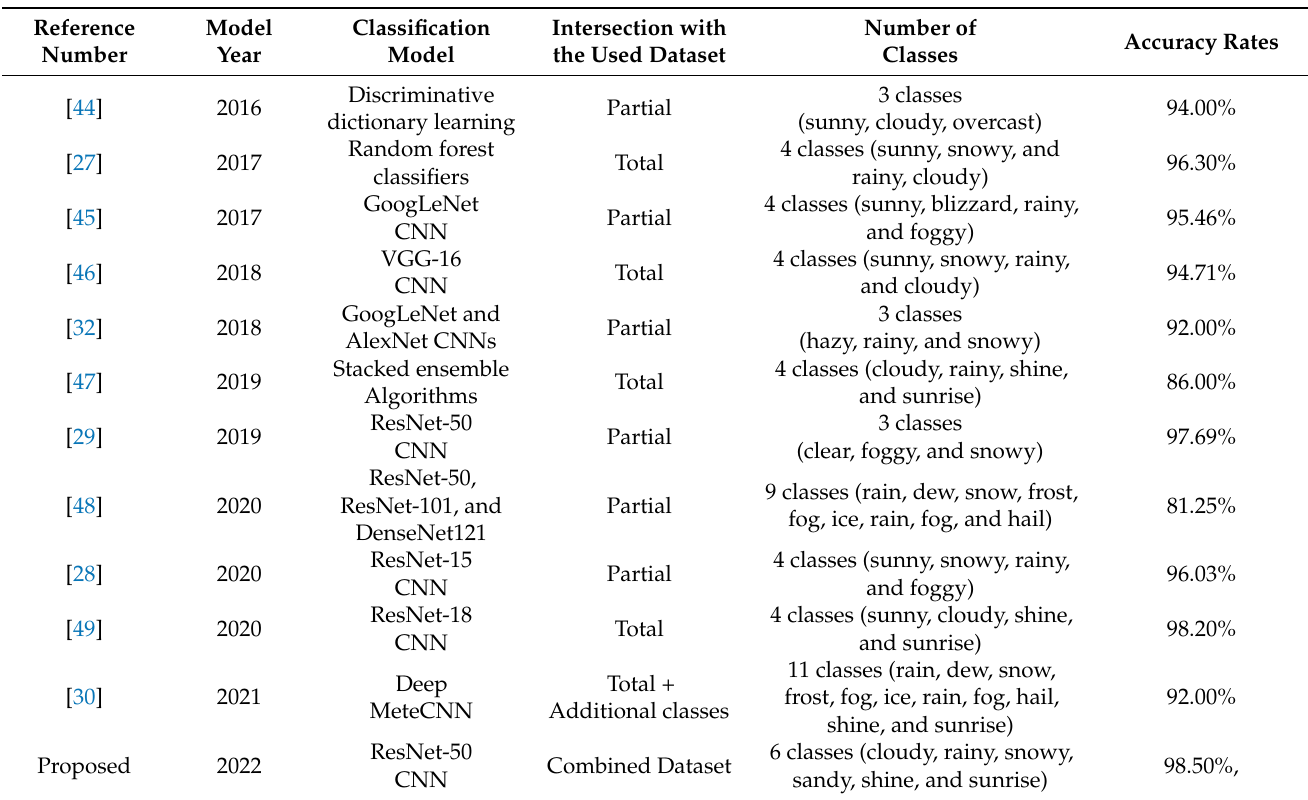
Table 3. Comparing our best results with other existing models in the